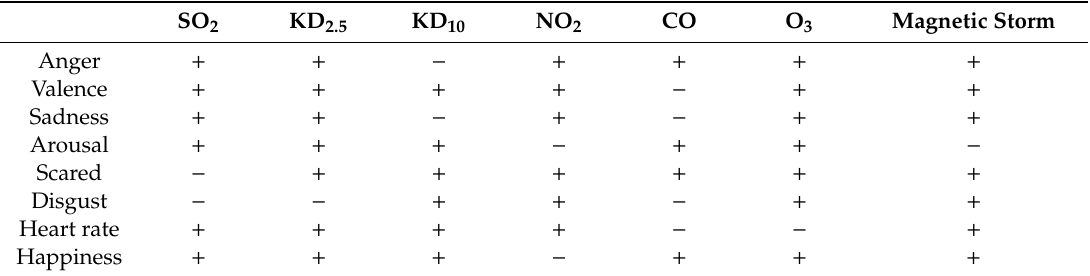
Table 3. Significance of links between AVABEPS and built environment pollution